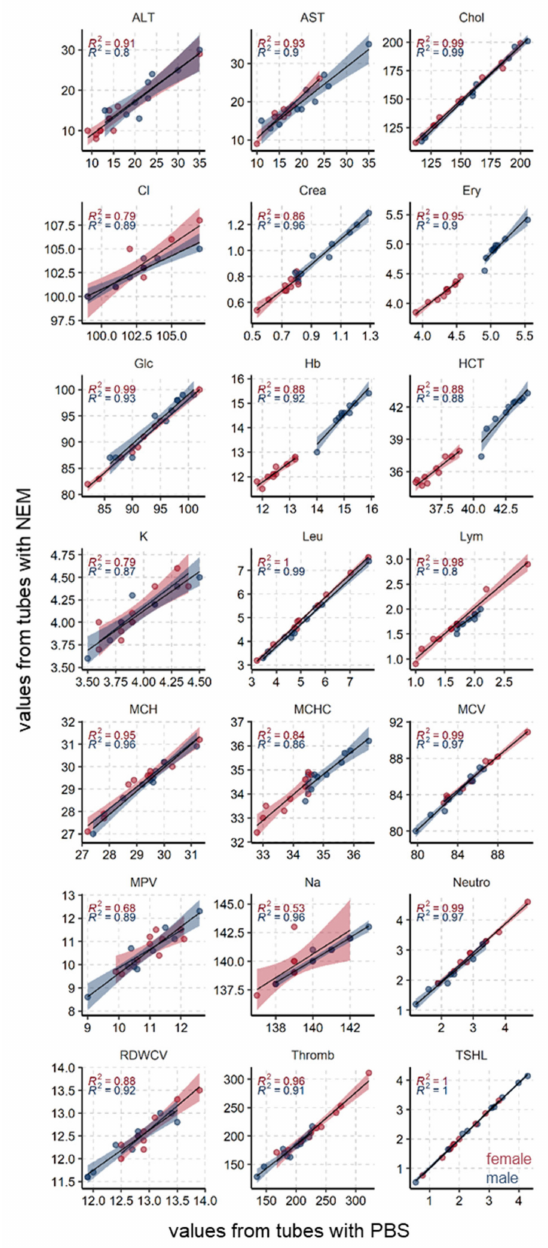
Figure 3. Direct comparison of clinical parameters measured from NEM- or PBS-spiked tubes. The linear correlation was calculated separately per gender, R 2 values are given in blue for males and red for females, the corresponding transparent stripes mark the 95% confidence